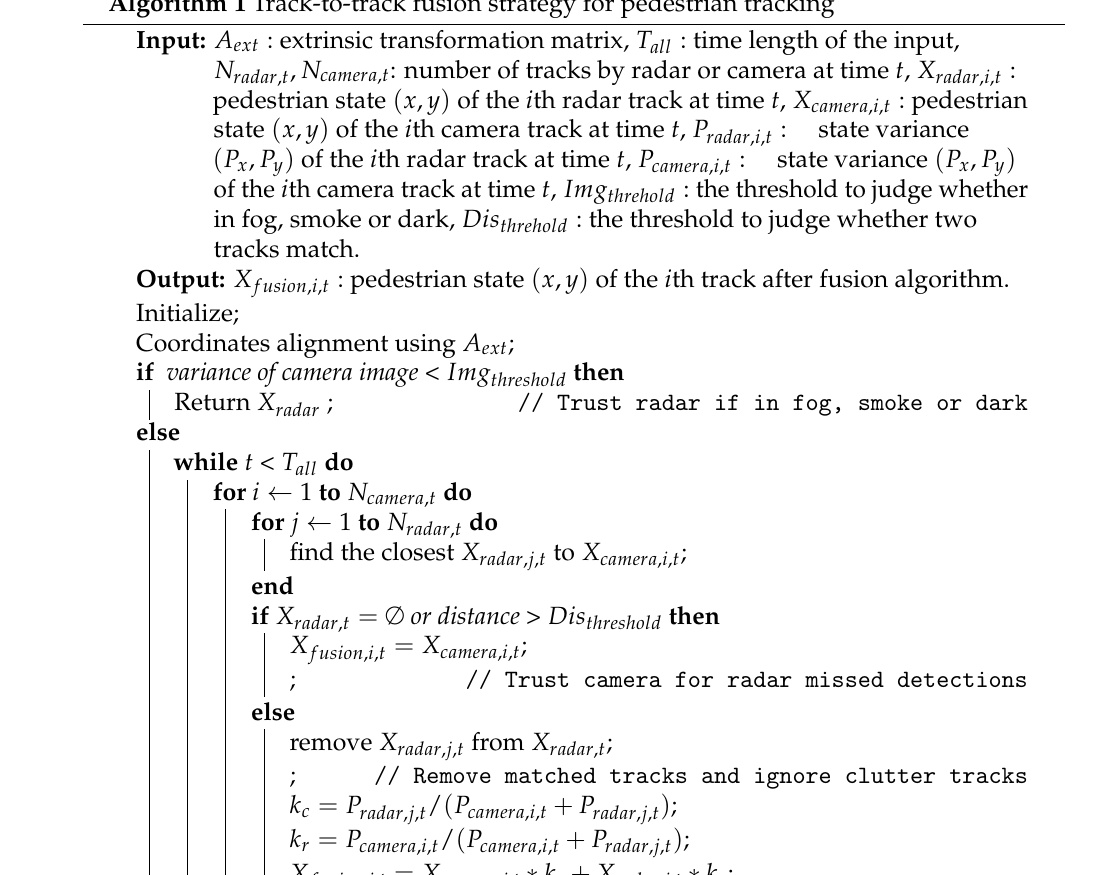
Algorithm 1 Track-to-track fusion strategy for pedestrian